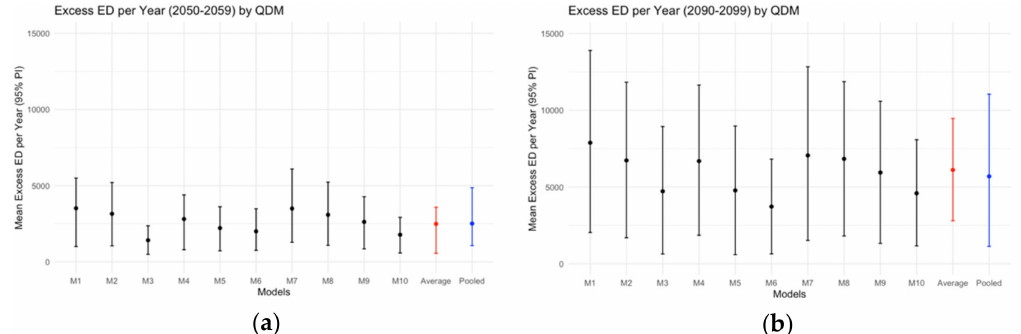
Figure 3. Projected excess temperature-related ED visits per year and projecquantile delta mapping. Specific global-climate model and regional-climate model combinations from NA-CORDEX are given as M1, M2, . . . , M10 in Table 1. ( a )